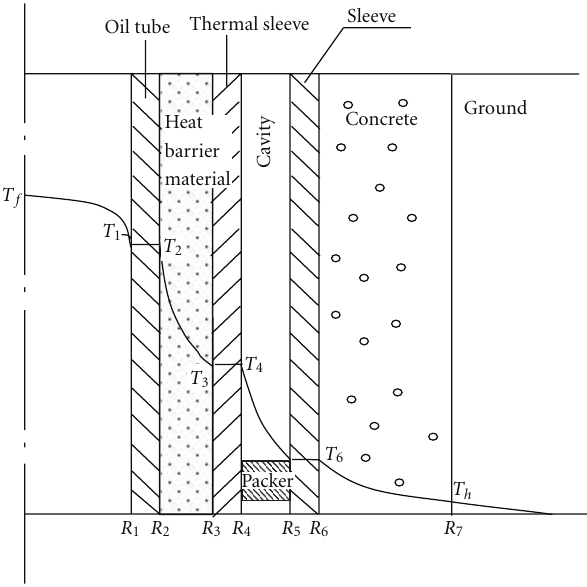
Figure 9: Structure of insulation oil well